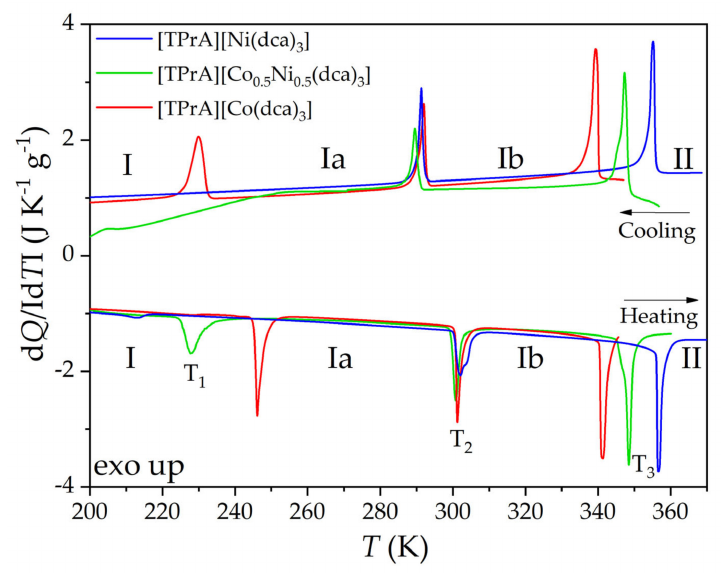
Figure 5. DSC curve of [TPrA][Co 0.5 Ni 0.5 (dca) 3 ] from 200 K to 360 K and comparison with the reported data for [TPrA][Co(dca) 3 ] and [TPrA][Ni(dca) 3 ] (data obtained from Reference [24]).